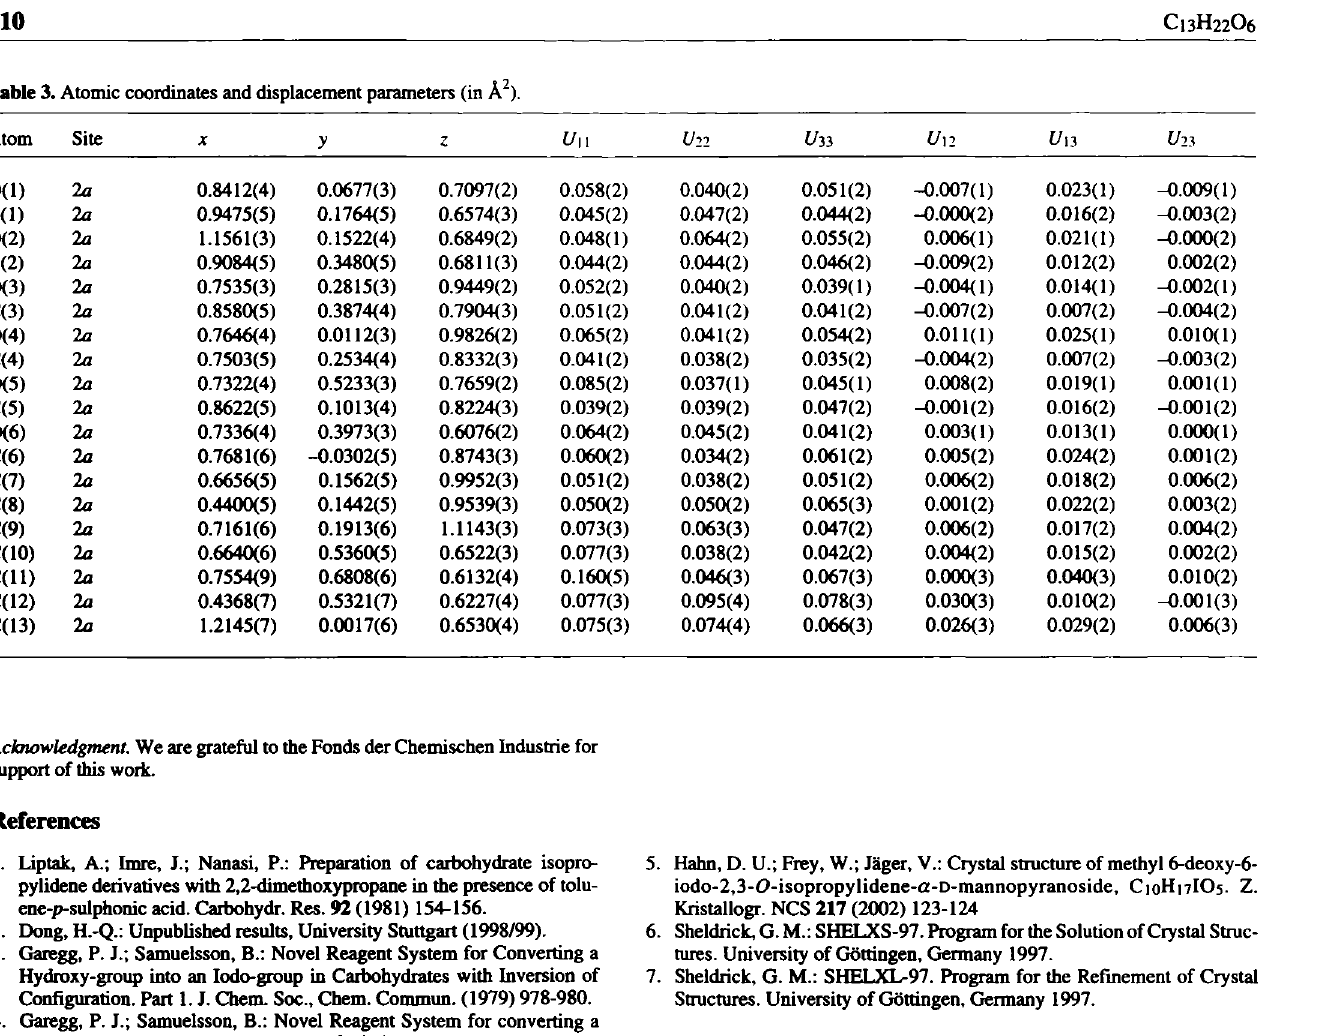
Table 3. Atomic coordinates and displacement parameters (in À 2